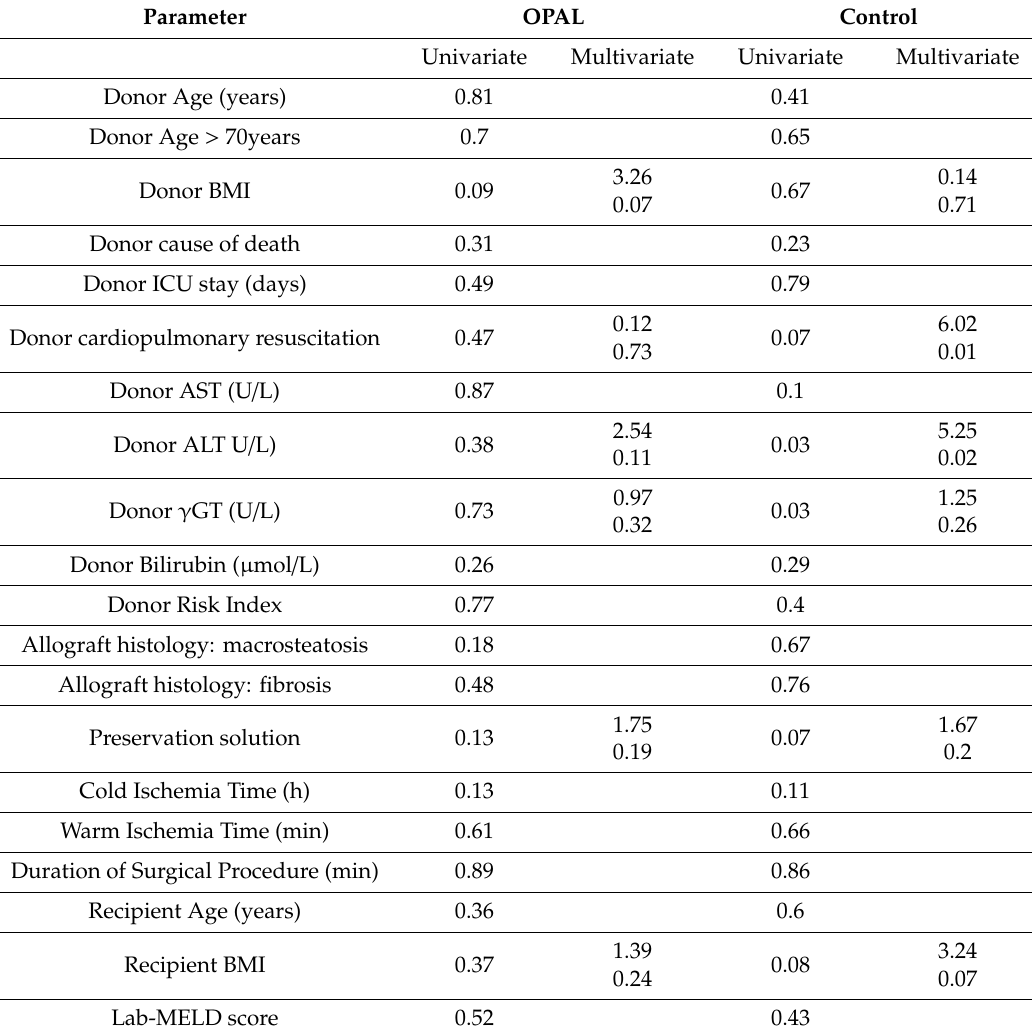
Table 3. Early allograft dysfunction; censored for treatment arm: Nominal logistic analysis, multivariate analysis and likelihood ratio test ( p